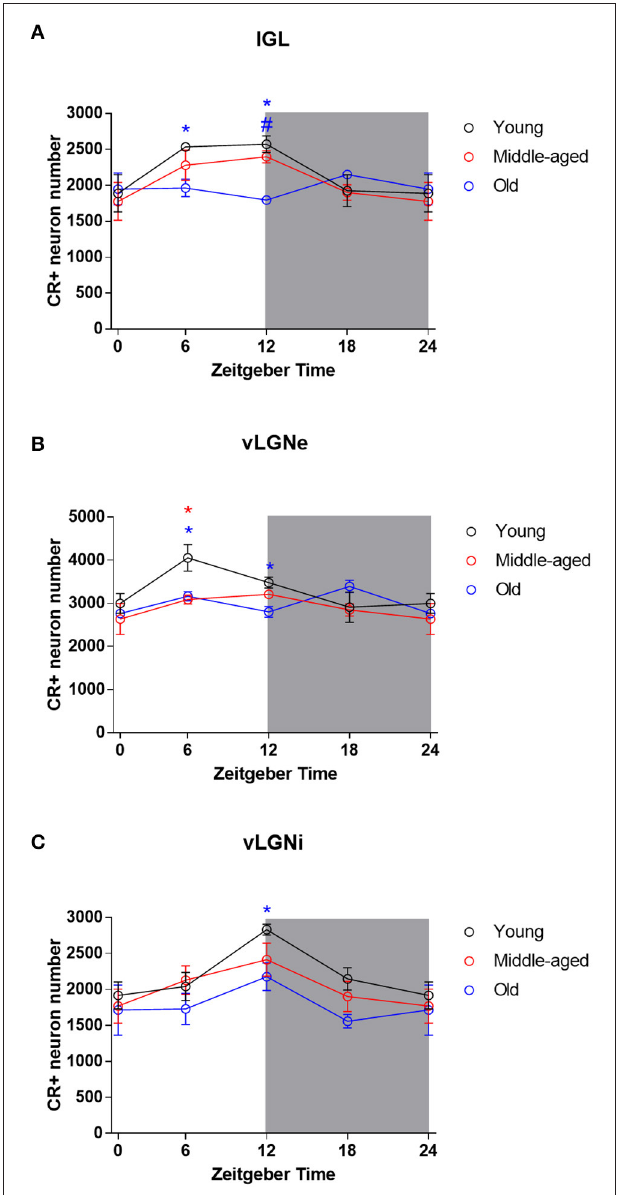
FIGURE 4 | Daily rhythmicity of CR expression in the IGL, vLGNe, and vLGNi. Stereological estimations of total CR cell number at each ZT in the IGL (A) , vLGNe (B) , and vLGNi (C) from young (black), middle-aged (red), or old (blue) animals. Data from ZT 0 are double plotted as ZT 24, to graphically represent the 24h of the day. Shaded gray areas represent the dark phase. Blue * p < 0.05 in young vs. old comparison. Blue # p < 0.05 in middle-aged vs. old comparison. Red * p < 0.05 in young vs. old comparison. Data are analyzed by two-way ANOVA followed by Tukey’s test for post-hoc comparison. Data are plotted as mean ±